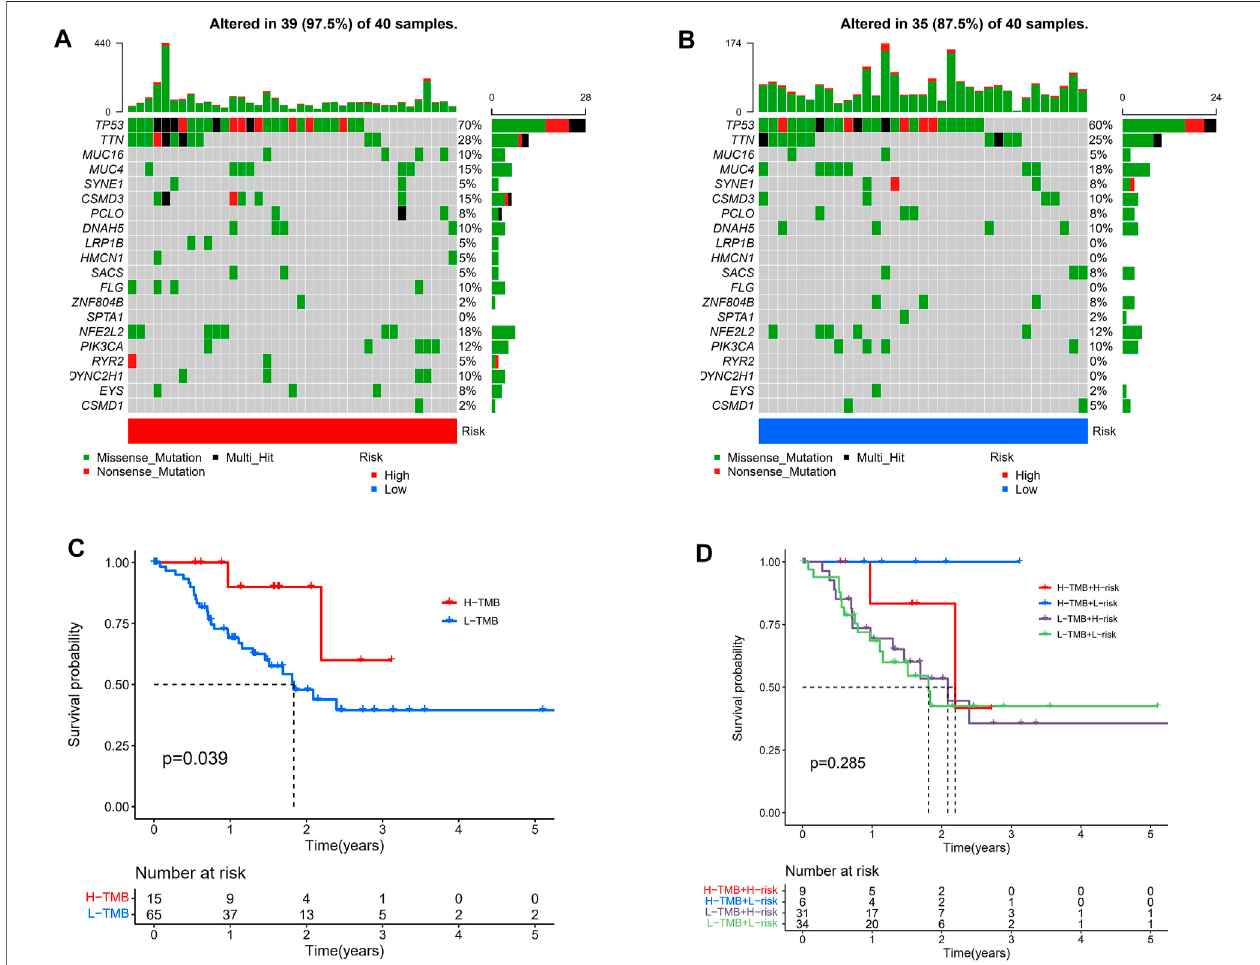
FIGURE 9 | Tumor somatic mutational analyses between high- and low-risk scores. Waterfall plot shows the mutation distribution of the top 20 most frequently mutated genesin the high-riskgroup (A) and low-riskgroup (B) . (C) Survivalprobability in ESCC patients between high- and low-TMB groups. (D) High TMB combined with low risk score has the best prognostic indicator signi fi